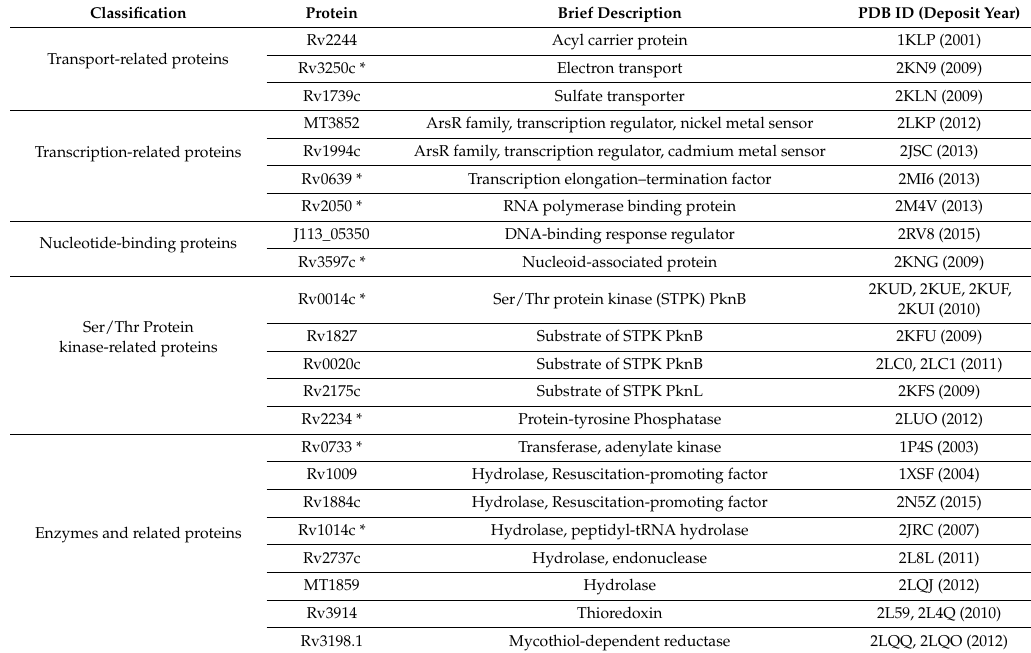
Table 1. Overview of NMR structures from M . tuberculosis